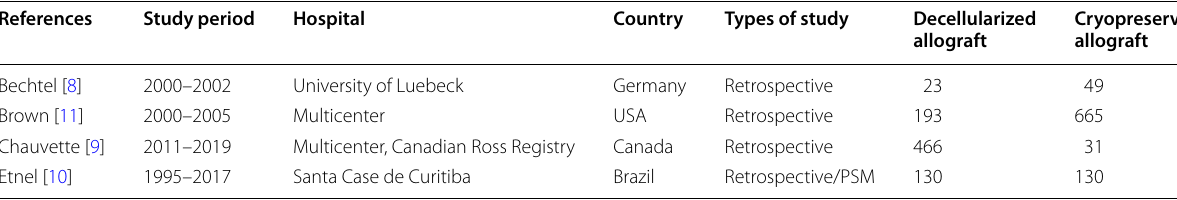
PSM: Propensity-score